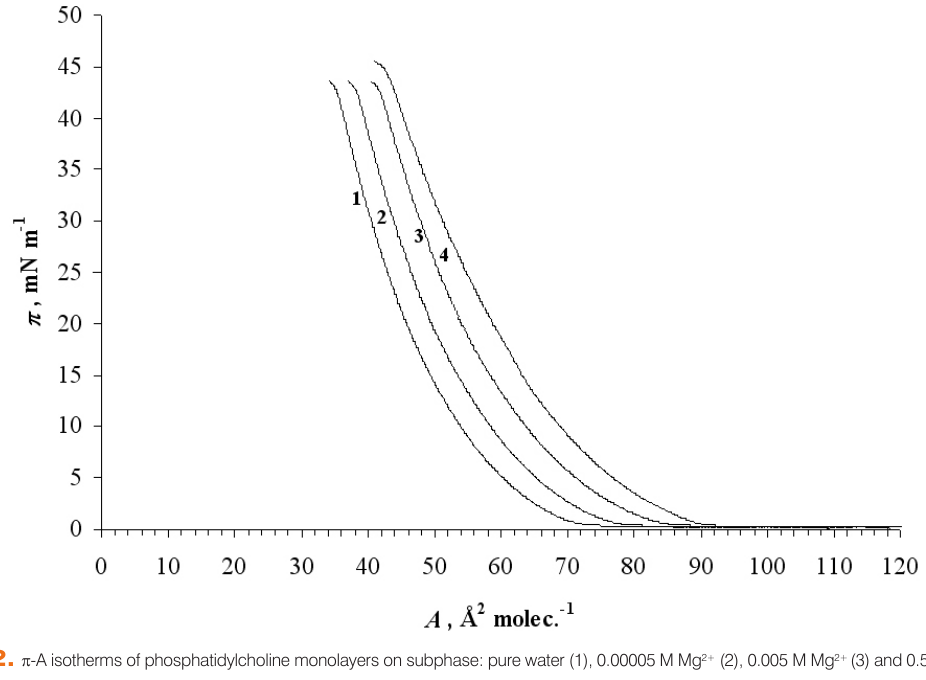
Figure 3. The dependence of total surface concentration of phosphatidylcholine, s , on the logarithm of Mg 2+ ions concentration, ( ■ the a form) at surface pressure a form; form and + experimental values, the theoretical values, − LMg L ~ 40 mN m -1 determined from Eqs. 14-16 by linear regression using The area occupied by one L Mg complex molecule 2 Excel 2003. The are 2.16×10 -6 mol m -2 and is less than the sum of the areas occupied by each component, reflecting its structure. The stability constants K per phosphatidylcholine, LMg + , and L Mg: 56, 77, and = 9.95×10 2 m 2 mol -1 and K = 3.87×10 4 m 2 mol -1 2 1 2 109 Å 2 molecule -1 respectively. The area occupied per